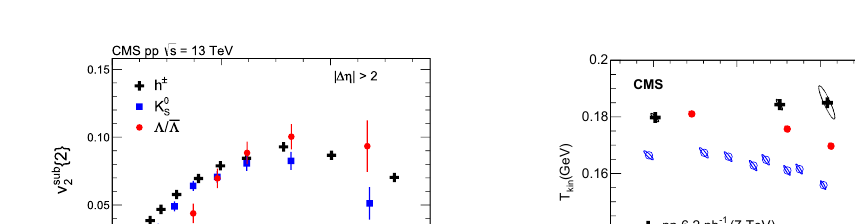
β T (cid:30) , (cid:31)